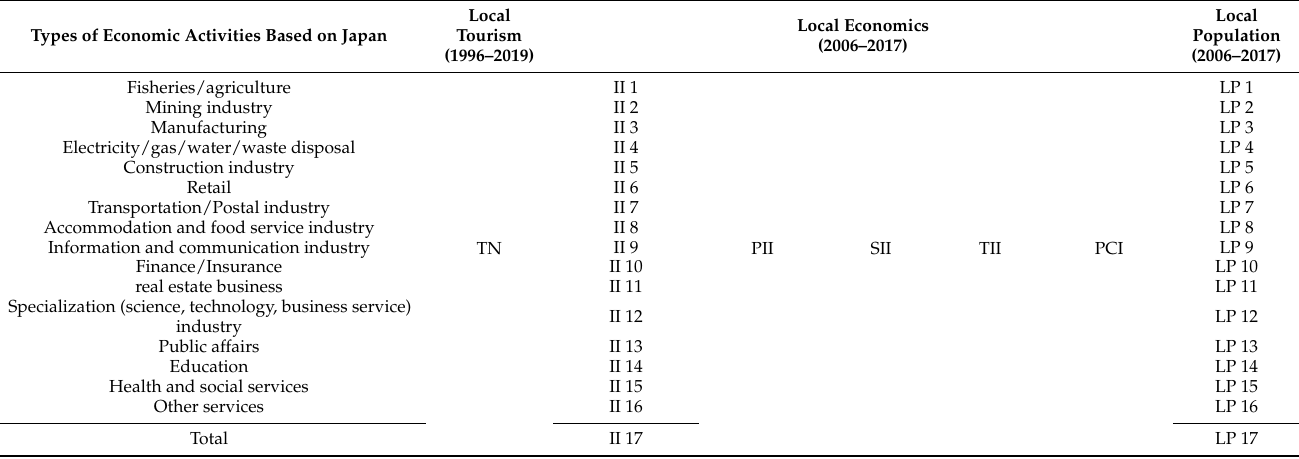
Table 2. Panel data: continuous variable